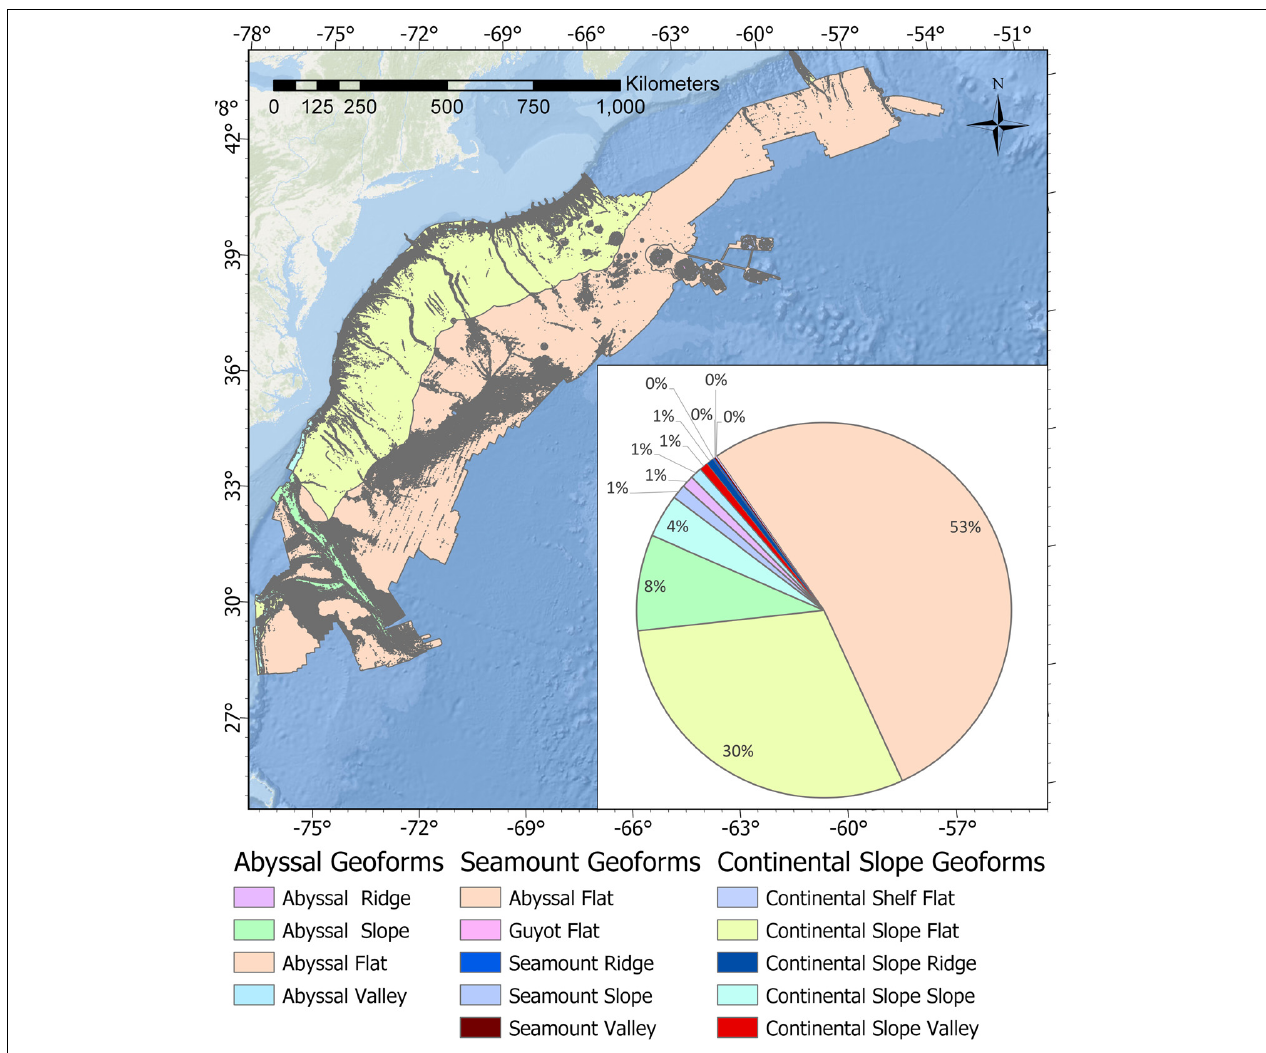
FIGURE 11 | CMECS geoform classifications for the entire Atlantic Margin region in the